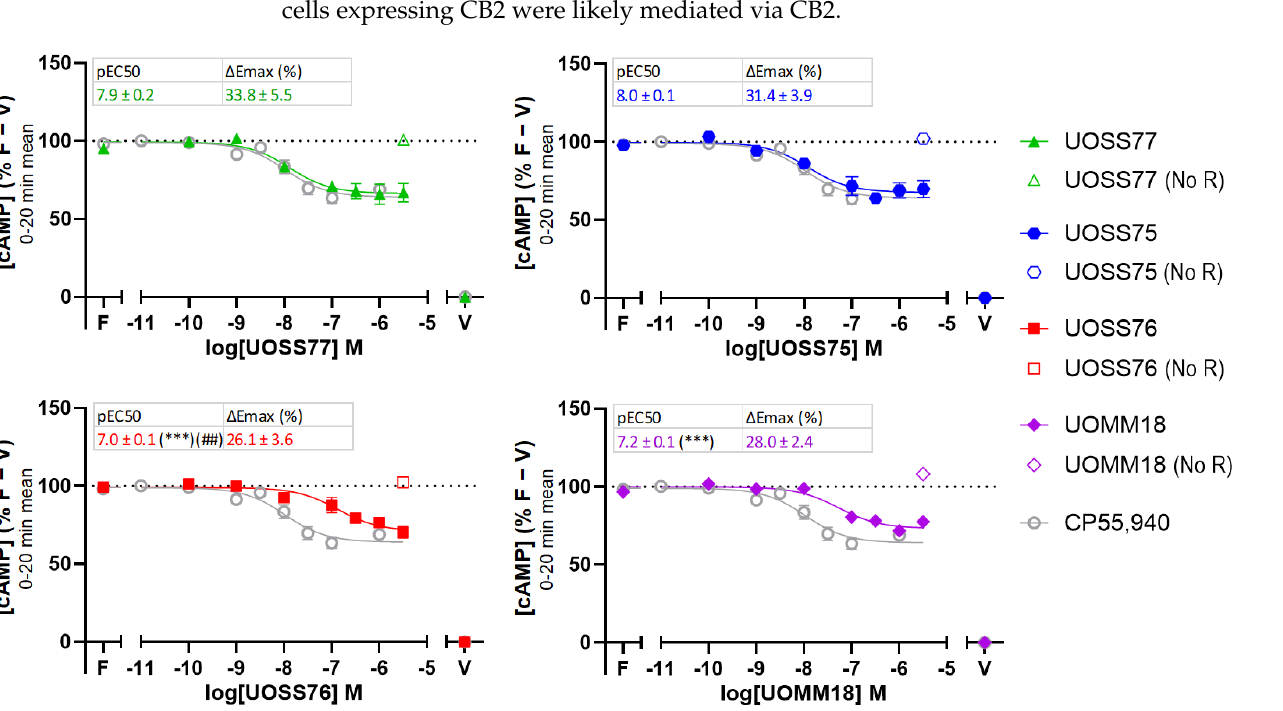
multiple points during the 20 min stimulation period, and deriving parameters of pEC 50 and E max for each ( Figrues 3 and S1). Data were normalised to forskolin-stimulation as these indicate greater reduction in cAMP relative to forskolin-stimulation. (100%) and vehicle-treated without forskolin (0%). Therefore, smaller E max values repre- sent more efficacious responses, as these indicate greater reduction in cAMP relative to